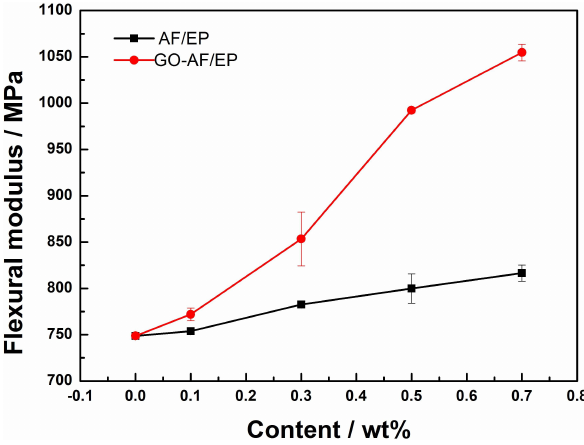
Figure 11: Flexural modulus of epoxy resin and AFs and GO- AFs/epoxy composites with different mass fractions of AFs and GO-AFs